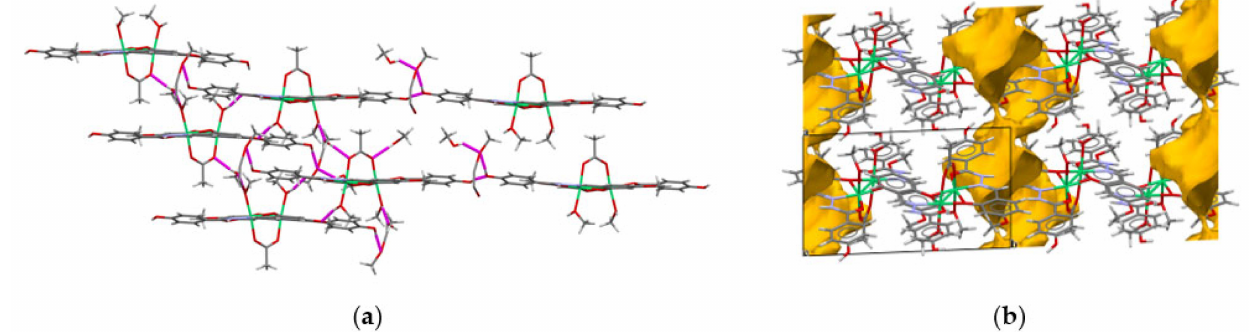
Figure 3. ORTEP view of molecular structures of: ( a ) 2 · 4.7MeOH and ( b ) 3 · MeOH · 0.63H 2 O · 0.5MeCN · HOAc. The displacement ellipsoids are drawn at the 50% probability level at 150(2) K. The solvent molecules of crystallisation have been omitted.